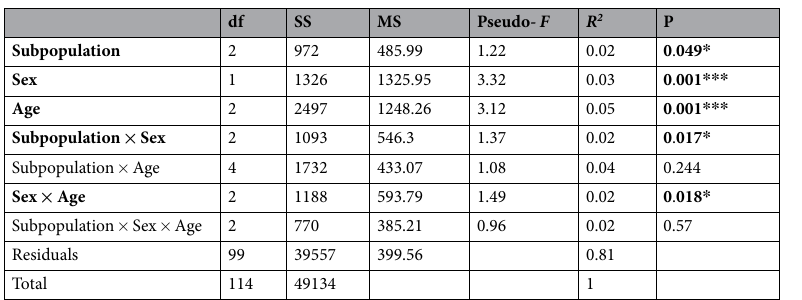
Table 1. Otter odour (VOCs) in relation to subpopulation, sex and age tested using PerMANOVA. df = degrees of freedom, SS = sum of squares, MS = mean squares. Bold font indicates statistical significance (p < 0.05) for both odour and genetic analyses. * p < 0.05, ** p < 0.01, *** p < 0.001. Modelled on three of the four regions, with SW subpopulation excluded because data deficiency for males precluded the interaction term. Female reproductive status was included in a female only data model, the genetic region: reproductive status interaction was not significant so the results are not presented.